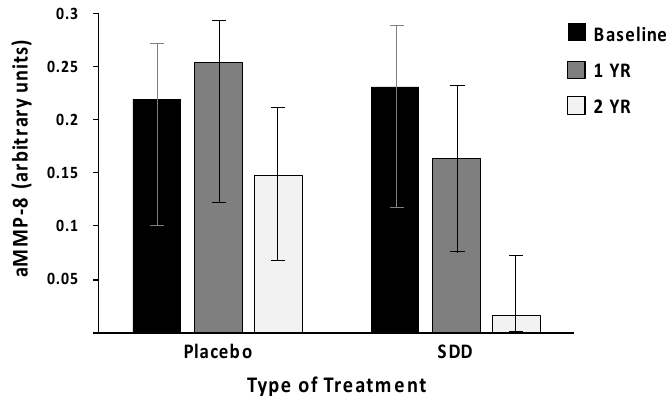
Figure 1. Subantimicrobial-dose doxycycline (SDD) administration reduces the risk of high levels of active MMP-8 (aMMP-8, neutrophil-type collagenase) in periodontal pockets (GCF) of post- menopausal women with chronic periodontitis, during a 2-year double-blind placebo-controlled study (n = 128 subjects). Based on both “intent-to-treat” and on “per-protocol” statistical analyses, the odds of high aMMP-8 were significantly reduced by 60 % (p = 0.006) and 78 % (p = 0.007), respectively, by SDD treatment (logistic regression analysis; bar plot with error bar (95% confidence interval) labeled, data modified from Golub et al. [17]). Based on the recent periodontitis classification of Tonetti et al. [15], the patients with grade C (i.e., severe-progressive periodontitis) prior to placebo (only standard treatment) or SDD treatment were reduced to grade A, i.e., minimally-progressive disease. Measurements of aMMP-8 levels are done by Western blot (arbitrary units) (Golub et al. [17]). Figure 2. Oral fluid (saliva, mouth rinse, gingival crevicular fluid (GCF), and peri-implant sulcular fluid (PISF)) lateral flow aMMP-8 point-of-care/chair-side immunoassay. Lane 1, two lines indicate aMMP-8 levels >20 ng/mL in GCF and a risk of progressive and active peri-implantitis before 3- month subantimicrobial-dose doxycycline (SDD) medication as adjunctive to scaling and root planing. Lane 2, one line indicates aMMP-8 levels <20 ng/mL in GCF and a reduced risk of progressive and active peri-implantitis at 3 months after scaling and root planing treatment and adjunctive SDD.